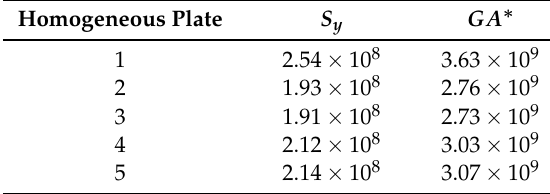
Table 3. Shear stiffness coefficients of LTW model (in N/m) and equivalent beams in the SLTW model (in N).